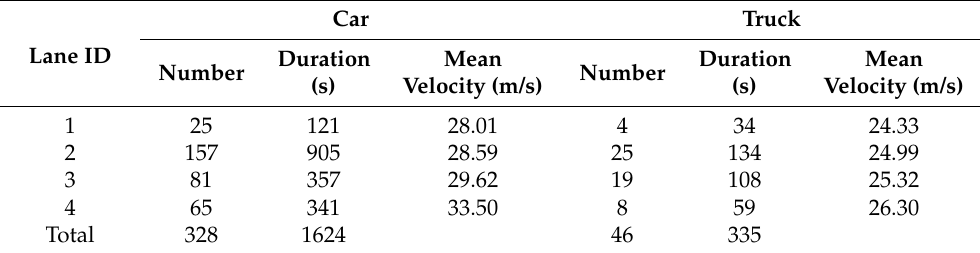
Table 2. List of lane-changing segment extraction results.